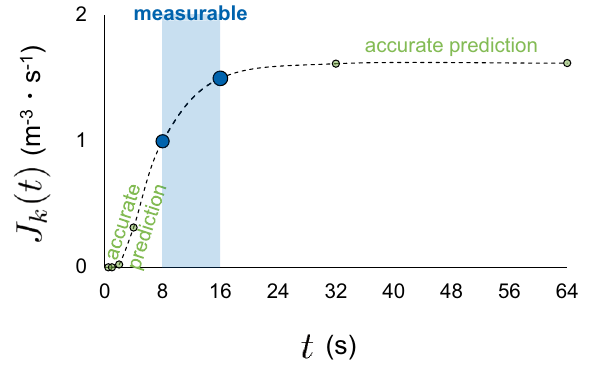
Fig. 2 The non-steady state nucleation rate J k ( t ) (m − 3 s − 1 ) vs. time t (s). If J k ( t ) can be accurately measured at only two times: J k ( 8 ) = 1 and J k ( 16 ) = 1.5 (large blue circles), J k ( t ) at discrete times before 8 s and after 16 s can be accurately predicted (small yellow-green cir- cles) from Proposition 2 and 1,